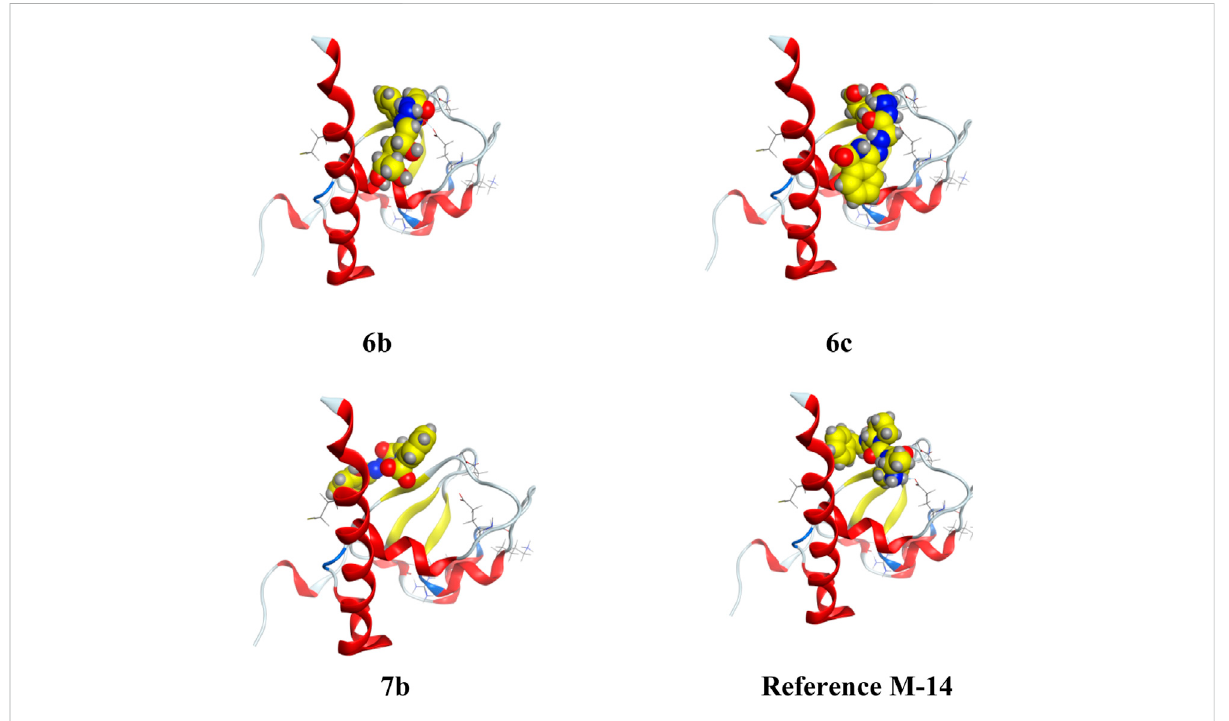
FIGURE 3 3D interaction of higher, lower, and reference compounds with 2OPZ ’ melanoma cancer